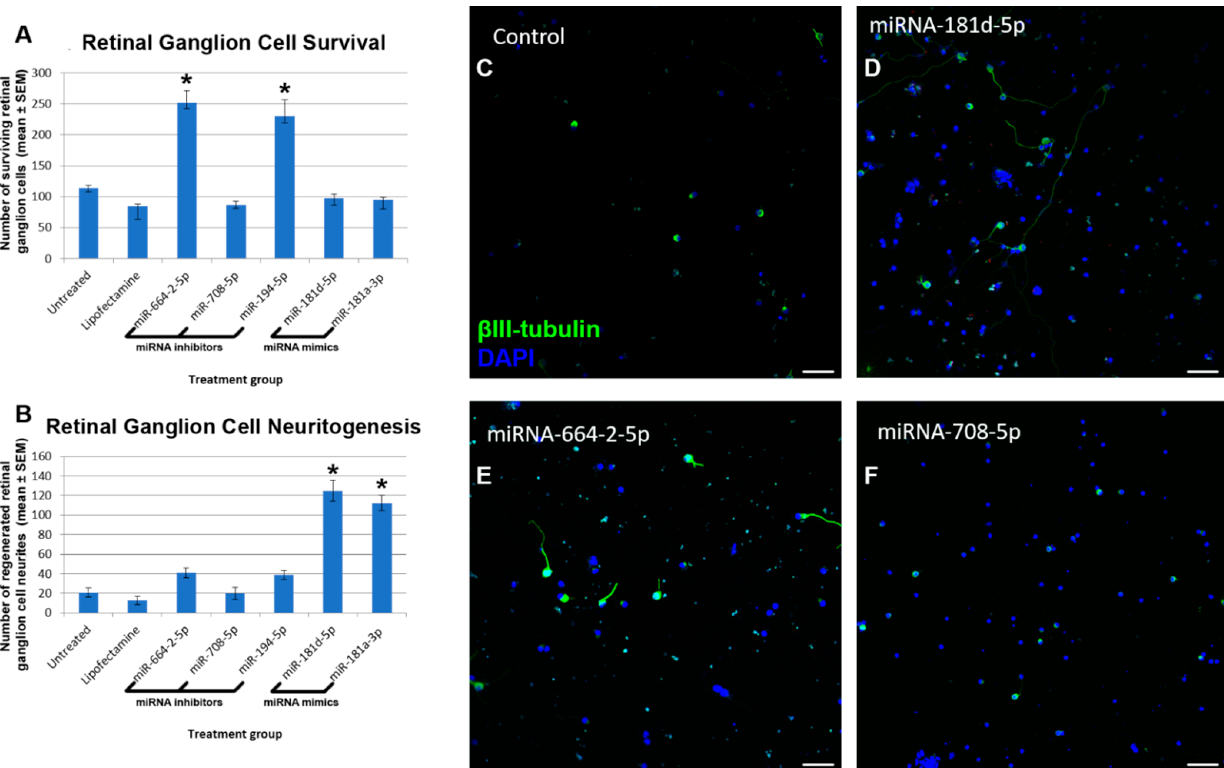
Figure 5. Effects of miRNA modulation on RGC neuroprotection and neuritogenesis. The number of RGC ( A ) and the number of RGC bearing neurites ( B ) in heterogenous retinal cultures with and without miRNA modulation is shown. Asterisks indicate significant differences from both untreated and lipofectamine only controls ( p < 0.05). miR-181a and miR181d refer to the use of miRNA mimics whereas miR-194, miR-708, and miR664-2 refer to the use of mirVana miRNA inhibitors. Representative images of heterogenous retinal cultures treated with: lipofectamine only ( C ), miR-181d mimic ( D ), miR-664-2 inhibitor ( E ), or miR-708 inhibitor ( F ). All images are representative of the entire culture, nine separate culture wells/treatment, with every 3 wells using a different animal (scale bars: 50 µm). Sections were stained for β III- tubulin (green) and DAPI (blue).